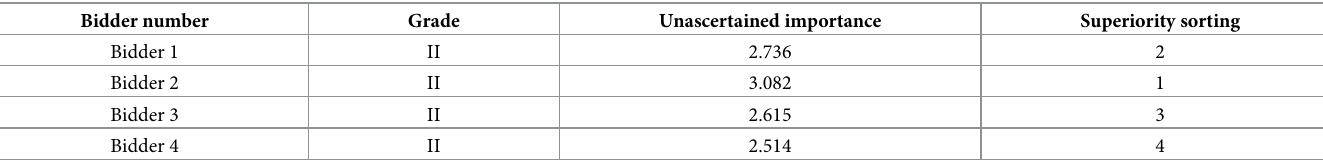
Table 3. The final bid evaluation